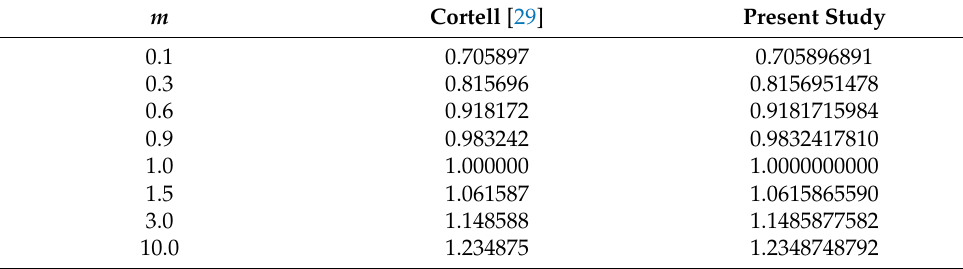
Table 1. Comparison values of f 00 ( 0 ) for various values of m with n = 1.0 and W e = 0.0. − m Cortell [31] Present Study 0.1